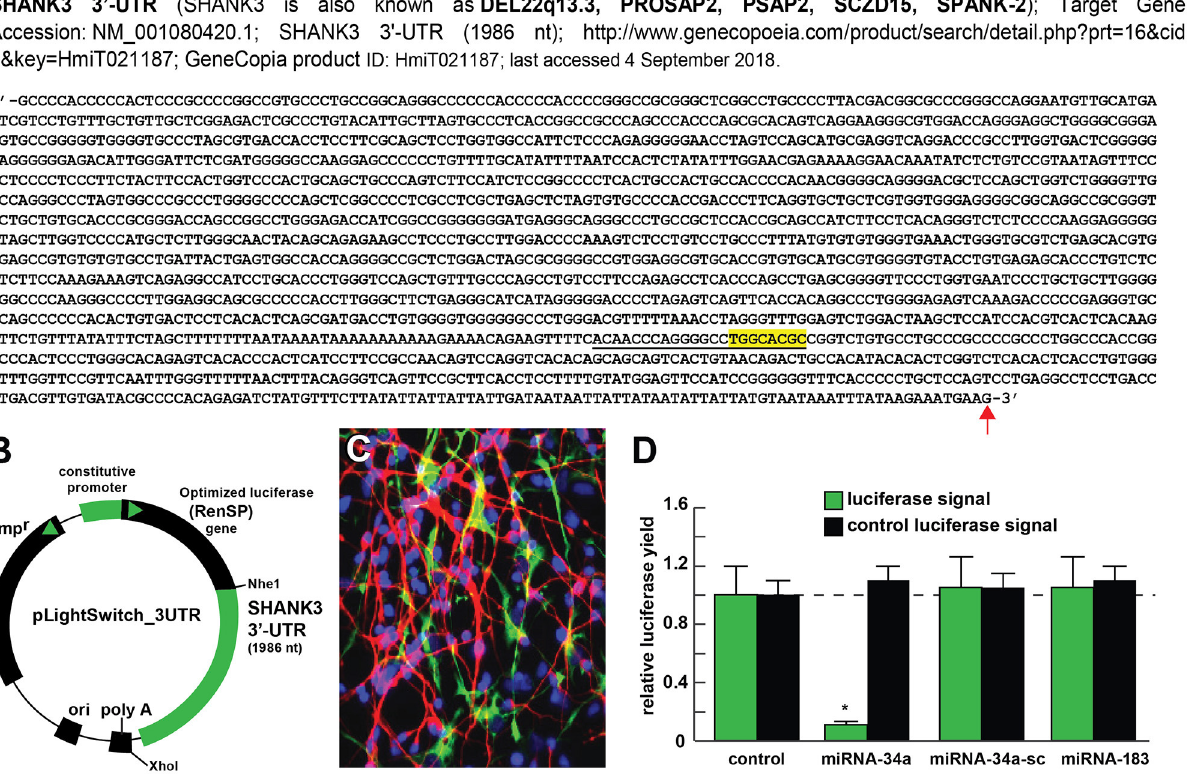
or miRNA-34a (data not shown); a dashed horizontal line set to 1.0 is included for ease of comparison; N = 6; * p < 0.001 (ANOVA). The results suggest a physiologically relevant miRNA-34a-SHANK3-mRNA-3 ′ UTR interaction and a miRNA-34a-mediated down-regulation of SHANK3 expression in HNG cells.